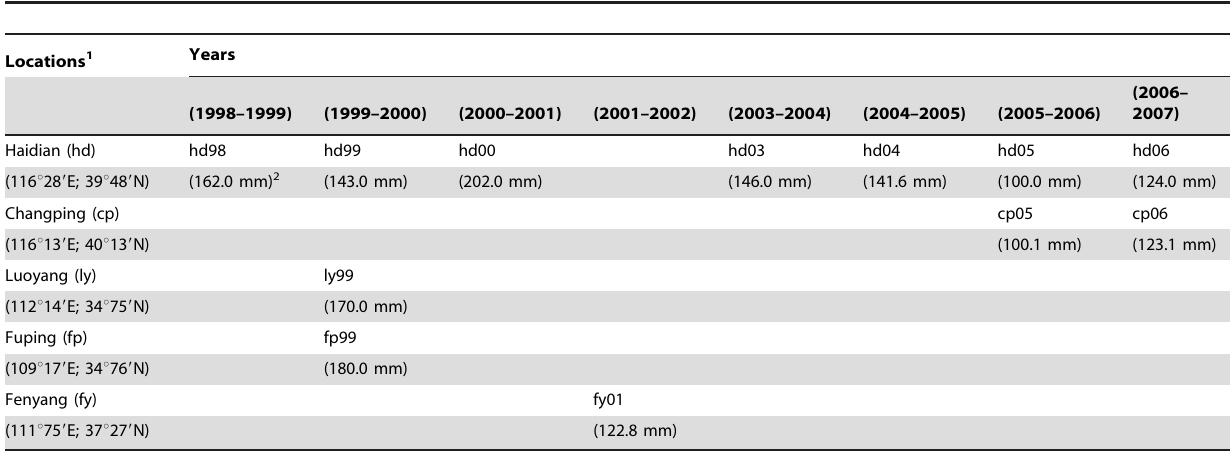
Table 11. Latitudes and longitudes of five locations and growing season rainfalls in each year 6 location combination.